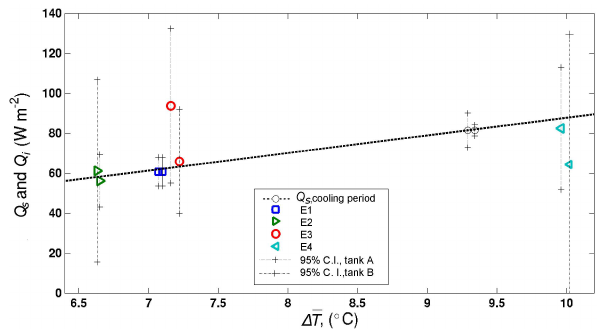
Fig. 8. Variation of derived heat fluxes ( Q s during cooling and Q i during ice growth) with temporally averaged temperature difference between water and air (at +8cm height) for each experiment and tank. Upper and lower 95% confidence intervals (according to lin- ear regressions in Fig. 7) are given with vertical black lines: tank A (dotted) and tank B (dash dot). Tank B points for the cooling pe- riod, E3 and E4, have been displaced in the x-axis by +0.06 units, for visibility. The heavy dashed line is the linear growth law calcu- lated from the cooling period heat flux as described in Sect.